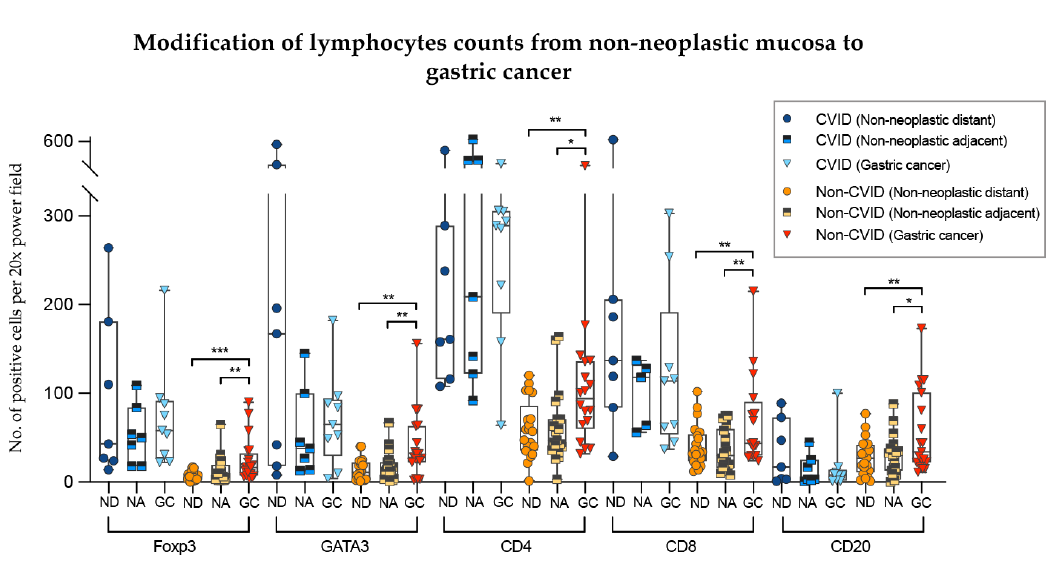
Figure 7. Modifications of lymphocyte counts from non-neoplastic mucosa to gastric cancer in CVID and non-CVID patients analysed separately. ND, non-neoplastic distant from tumour; NA, non-neoplastic adjacent to tumour; GC, gastric cancer. Statistically significant results are highlighted by asterisks: * p ≤ 0.05; ** p ≤ 0.01; *** p ≤ 0.001.